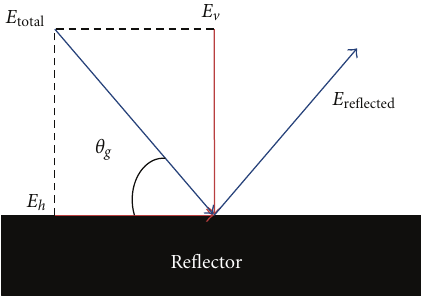
Figure 1: Reflected electromagnetic